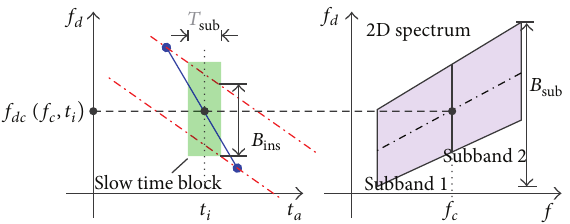
Figure 2: The subaperture division. (a) The TFD of sliding spotlight. (b) 2D spectrum of the whole bandwidth